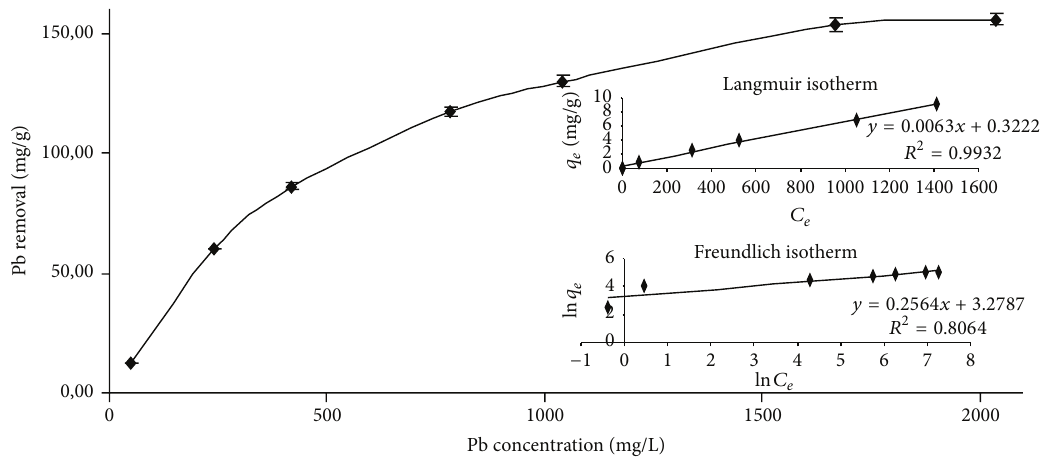
Figure 7: The effect of concentration on the adsorption of Pb (II). Table 9: Comparison of lead removal with different